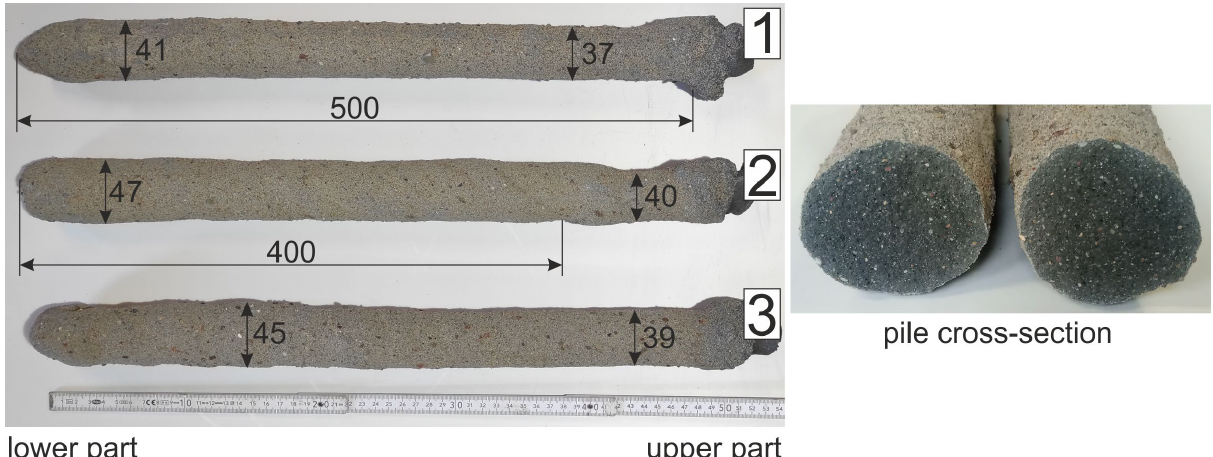
Figure 14. Dimensions of pumped displacement